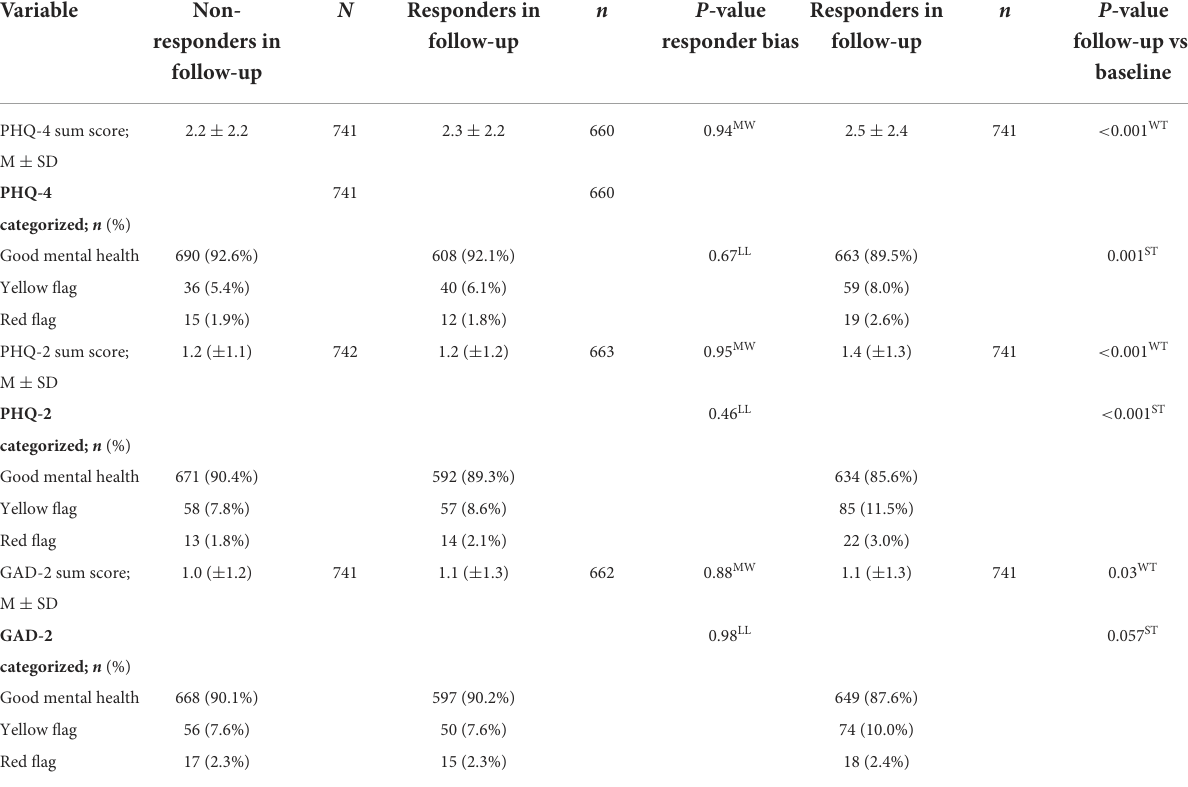
TABLE 2 Mental health outcomes in survey responders vs. non-responders at follow-up. N Responders in n P -value n P -value Variable Non- Responders in responders in follow-up responder bias follow-up follow-up vs. follow-up